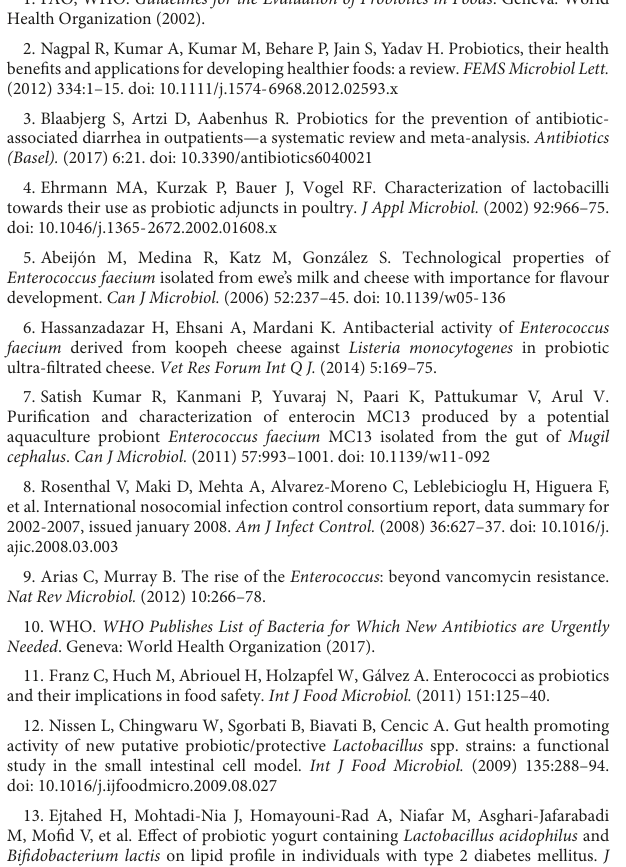
SUPPLEMENTARYFILE2 Detailed information of the core genes in the studied genomes. SUPPLEMENTARYFILE3 Detailed information of the accessory genes in the studied genomes. SUPPLEMENTARYFILE4 Detailed information of the unique genes in the studied genomes. SUPPLEMENTARYFILE5 Detailed information of the Genomic Islands in E. faecium